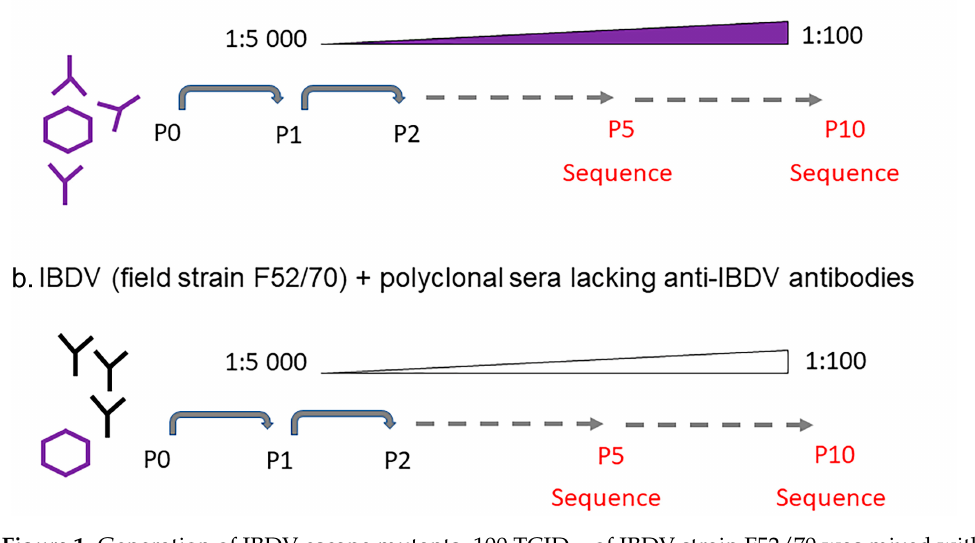
Figure 1. Generation of IBDV escape mutants. 100 TCID 50 of IBDV strain F52/70 was mixed with 1:5000 of either ( a ) hyperimmune serum obtained from inoculating chickens with IBDV vaccine strain 2512, or with ( b ) negative control serum that did not contain any anti-IBDV antibodies. The mixture was incubated for 1 h at 37 °C, and added to DT40 cells, which were then incubated for 3 days at 37 °C, lysed, and the quantity of virus determined by a TCID 50 assay. Then, virus at each passage was mixed with increasing concentrations of serum and passaged onto fresh DT40 cells. This protocol was repeated for ten passages. The sequences of the HVR of the viruses at passages 5 and 10 were determined by Sanger sequencing.